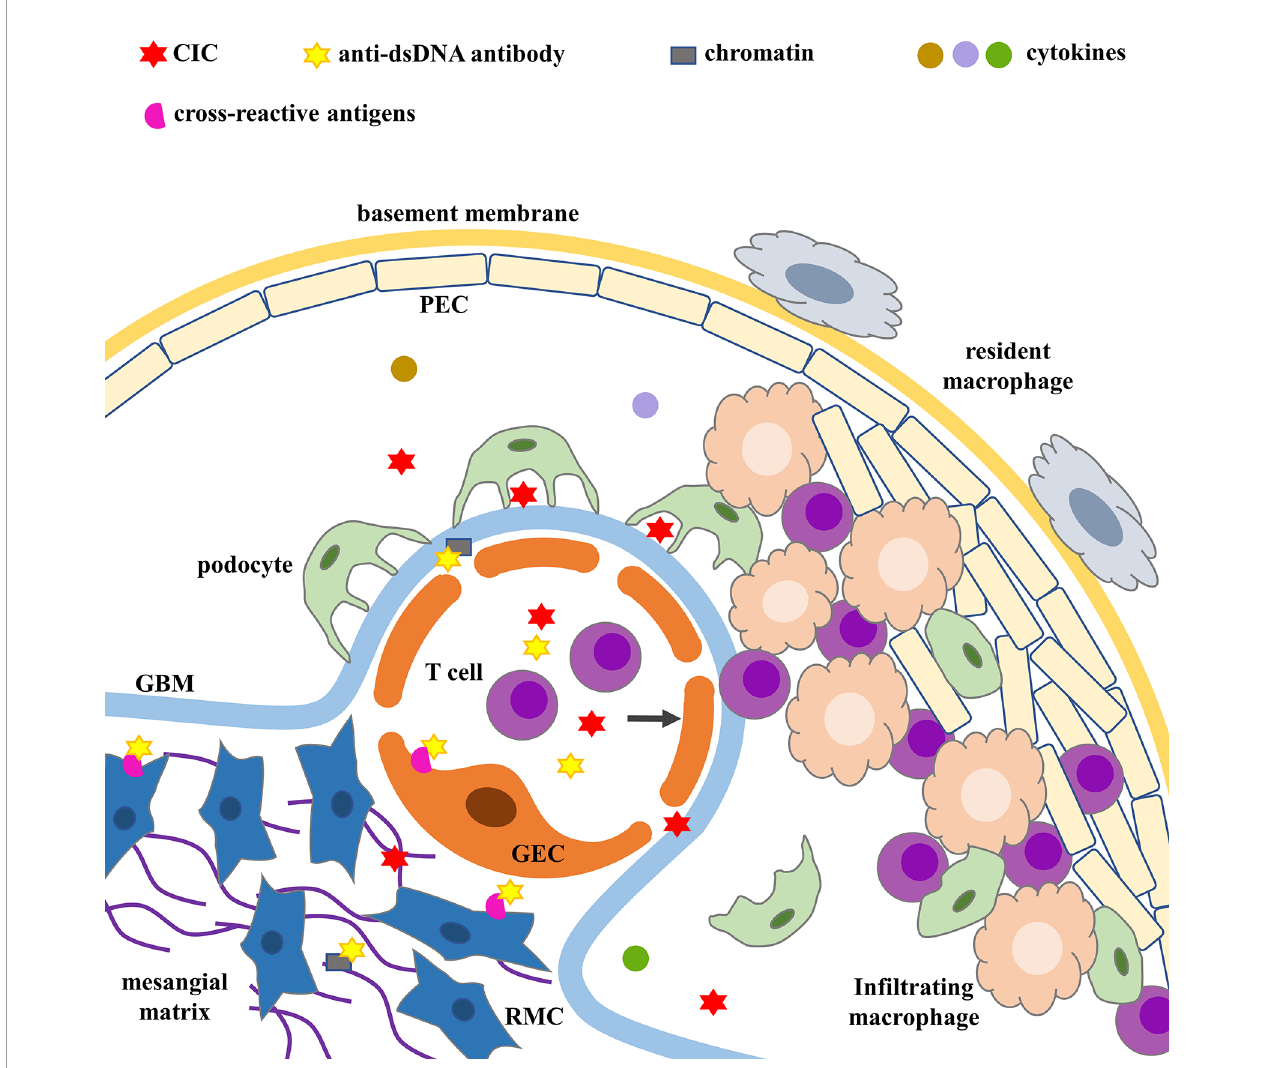
FIGURE 1 | ICs deposition and glomerular injury. Cross-reactive antigens include annexin II, a -actinin, ribosomal P protein on RMCs ’ surface and membrane proteins with M.W. of 30 – 35, 44, 68, 110, and 180kDa on GECs ’ surface. CIC, circulating immune complex; GBM, glomerular basement membrane; GEC, glomerular endothelial cell; PEC, parietal epithelial cell; RMC, renal mesangial